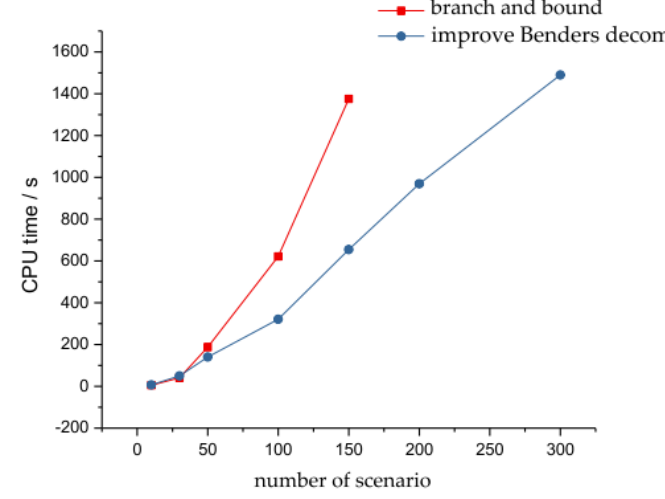
Figure 10. Computation efficiency.